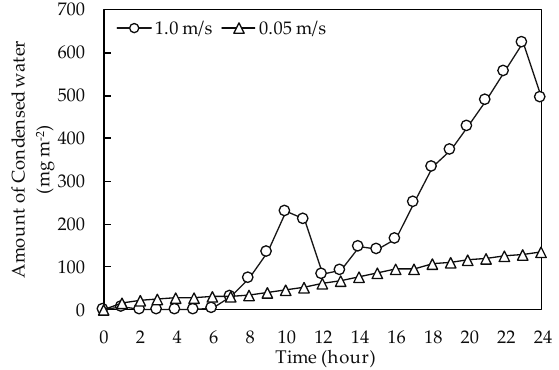
Figure 16. Amount of condensed water of the underfloor space relevant to evaporation and condensation during a day.